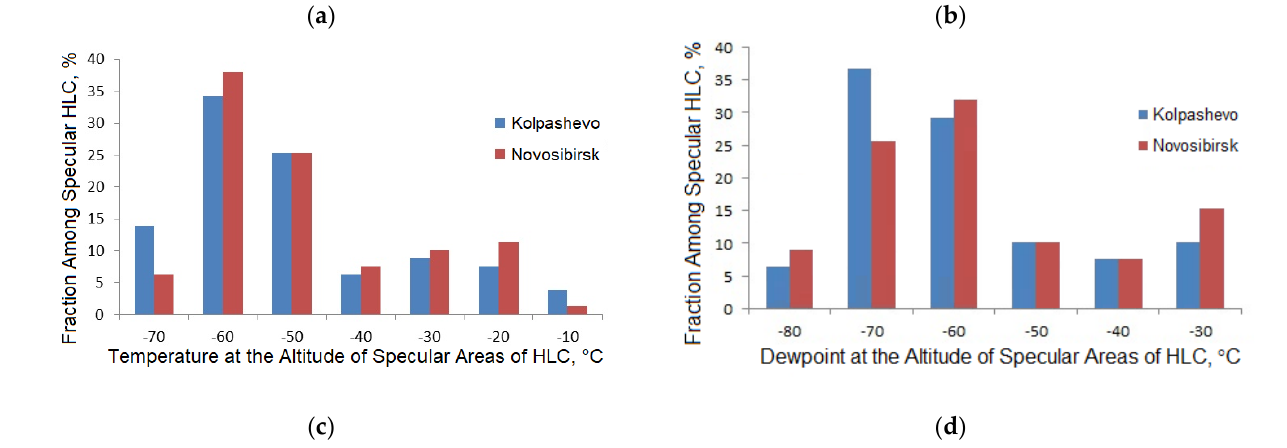
Figure 7. Distribution of altitudes of the formation of HLCs with horizontally oriented ice particles detected with HAMPL ( a ) and corresponding values of relative humidity ( b ), air temperature ( c ), and dew point ( d ) at their altitudes based on the radiosonde observation data [25] (2016–2020). Table 2. Meteorological conditions [25] at the altitude of the HLC registered with HAMPL (1 June